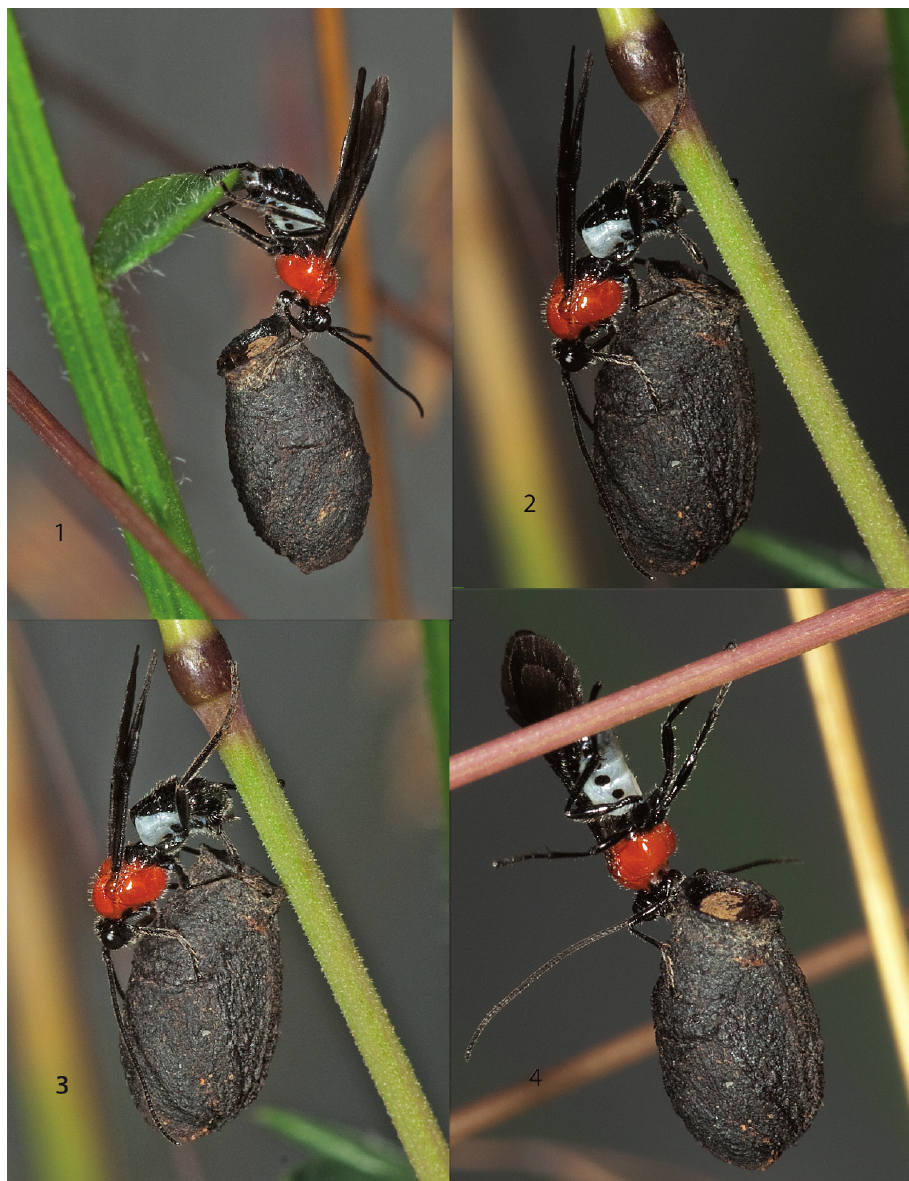
Figures 1–4. Sequential photographs of female Pycnobraconoides sp. carrying and probing detached cryptocephaline chrysomelid beetle larva